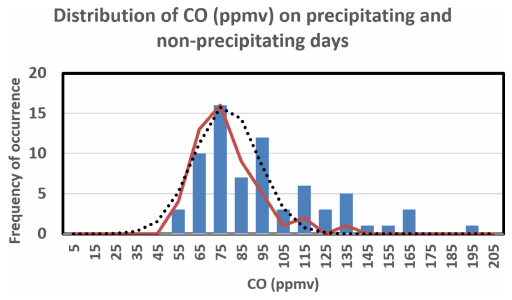
Figure 17. The carbon monoxide (CO) concentrations for precipi- tating (red curve) and non-precipitating days (blue bars). A Gaus- sian fit to the precipitating data is shown by the dotted